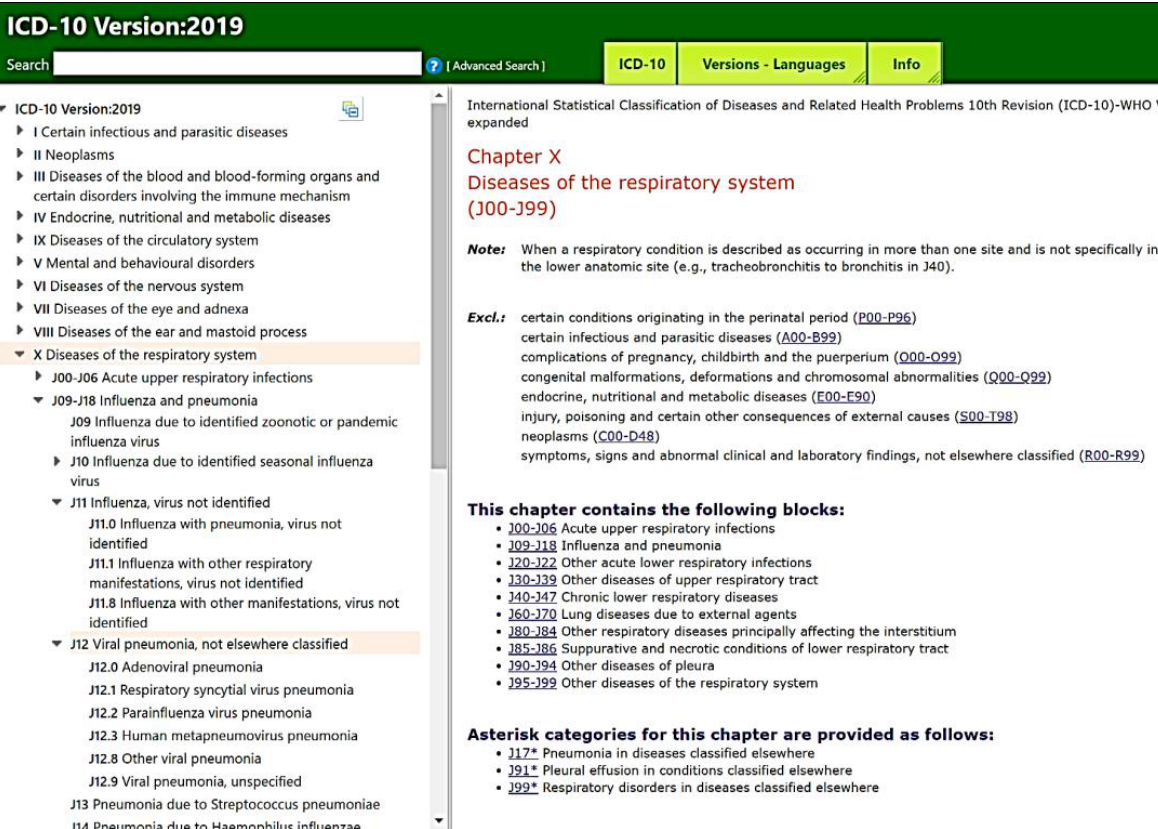
Figure 2. An example of ICD-10 hierarchical structure of the respiratory system diseases.